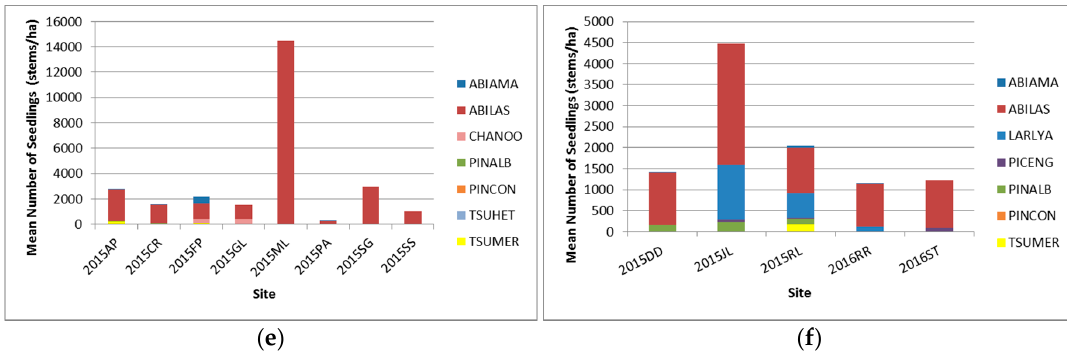
Figure 2. Site composition in 2015/2016 for trees, saplings, and seedlings. Mean tree basal area by species in ( a ) Mount Rainier National Park and ( b ) North Cascades National Park Service Complex. Mean sapling density by site in ( c ) Mount Rainier National Park and ( d ) North Cascades National Park Service Complex. Mean seedling density by site in ( e ) Mount Rainier National Park and ( f ) North Cascades National Park Service Complex. Species abbreviations are as follows: ABIAMA = silver fir ( Abies amabilis ), ABILAS = subalpine fir ( Abies lasiocarpa ), CHANOO = Alaska yellow cedar ( Chamaecyparis nootkatensis ), LARLYA = subalpine larch ( Larix lyallii ), PICENG = Engelmann spruce ( Picea engelmannii ), PINALB = whitebark pine ( Pinus albicaulis ), PINCON= lodgepole pine ( Pinus conto r ta ), PINPON = ponderosa pine ( Pinus ponderosa ), TSUHET = western hemlock ( Tsuga heterophylla ), and TSUMER = mountain hemlock ( Tsuga mertensiana ).